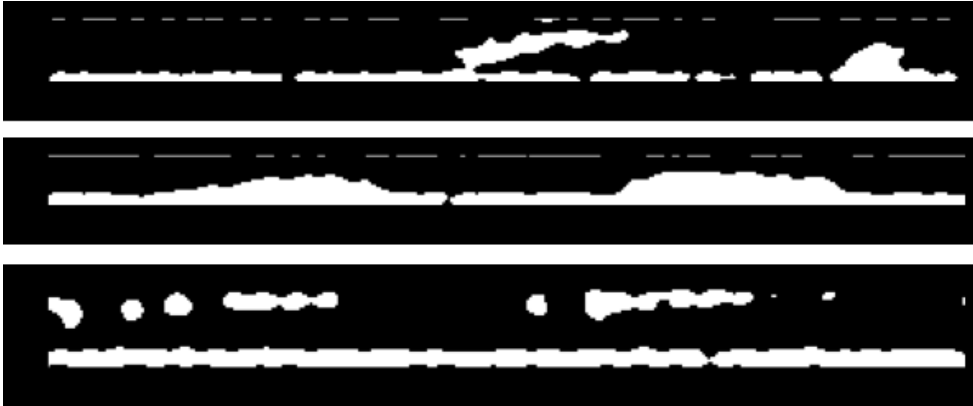
Figure 4. Data from Figure 1 after going through a deconstruction and reconstruction via